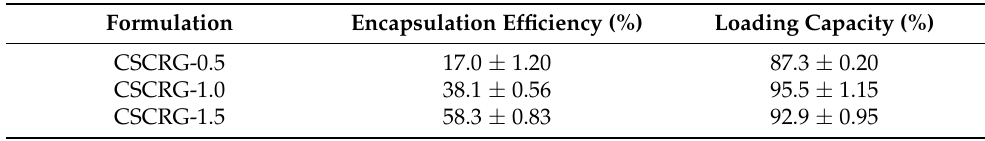
Table 4. Encapsulation and loading capacity of mancozeb in CSCRG NPs.